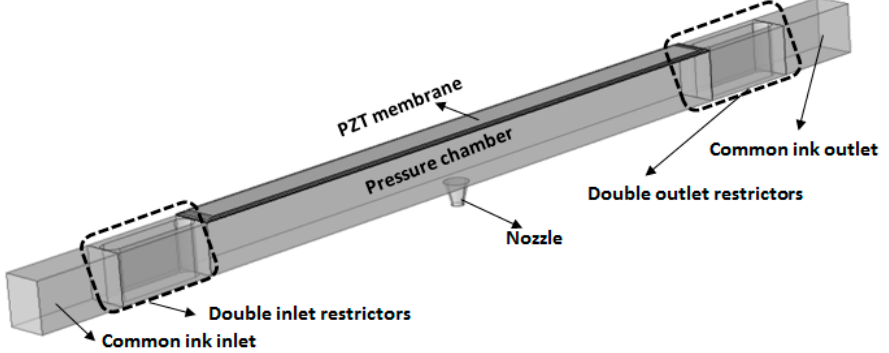
Figure 1. 3D view of double-restrictor recirculating piezoelectric inkjet printhead (D-RPIP) design.